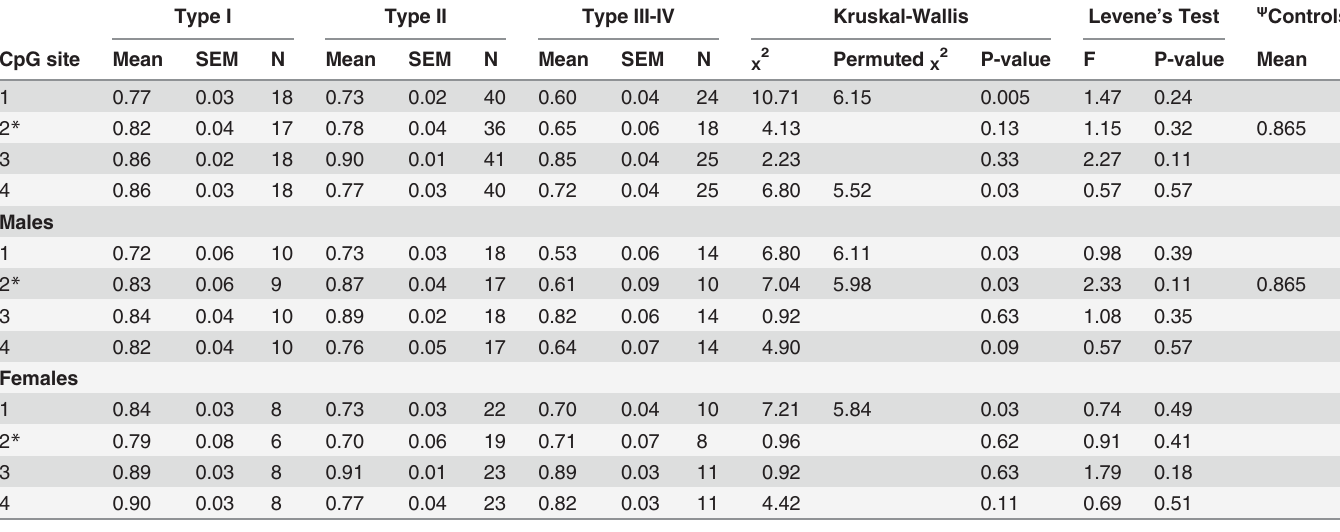
Table 3. Methylation levels (%) of CpG sites in the analyzed region of 5 ’ UTR of SLC23A2